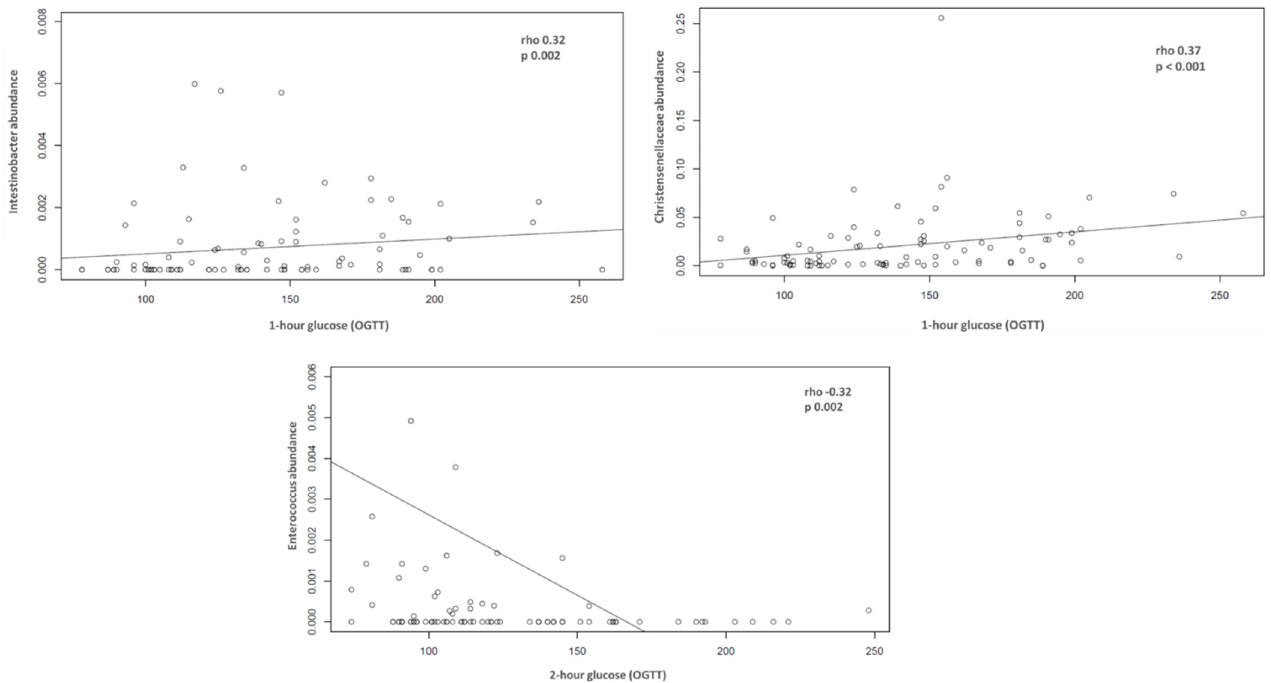
Figure 4. Correlation between bacteria and fasting and post load plasma glucose in the third trimester of pregnancy.